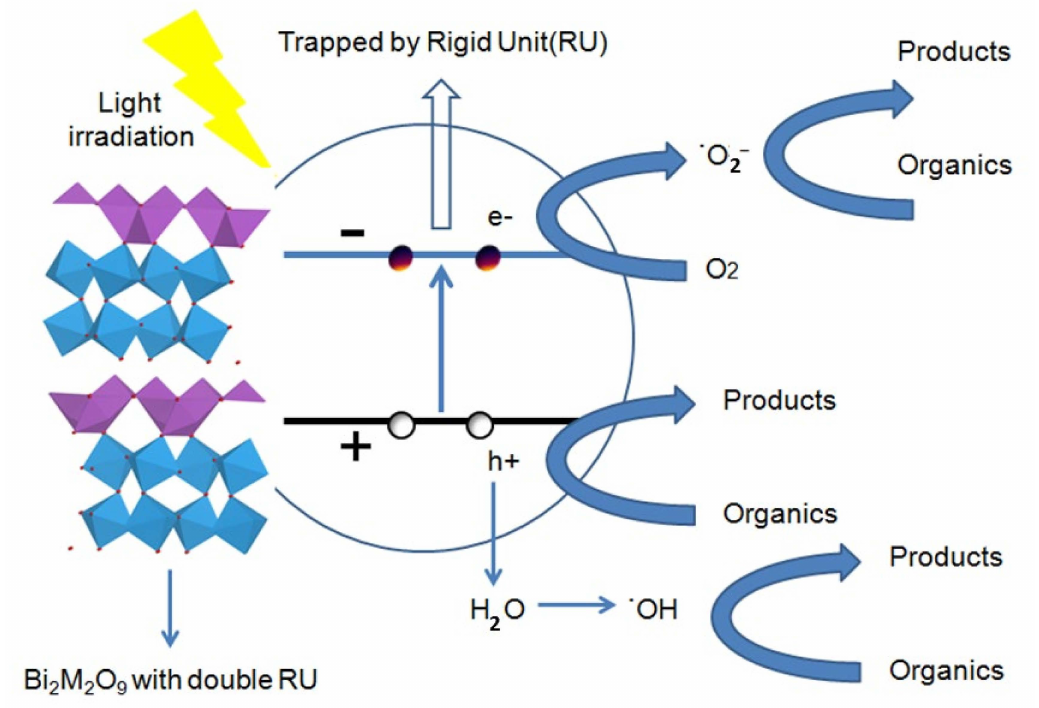
Figure 12. Schematic illustration of the mechanism of Bi 2 M 2 O 9 photocatalyst under visible-light